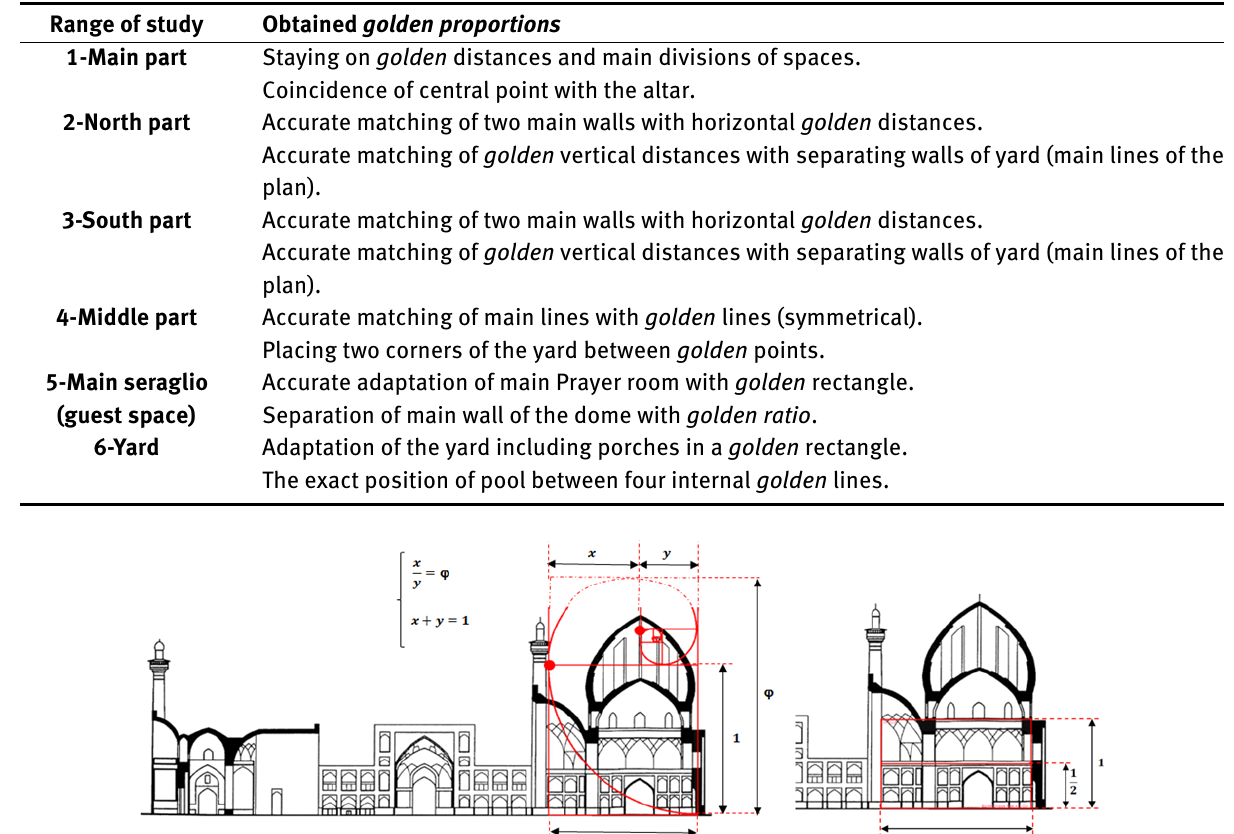
ysis shows the presence of golden ratio in this building at an excellent